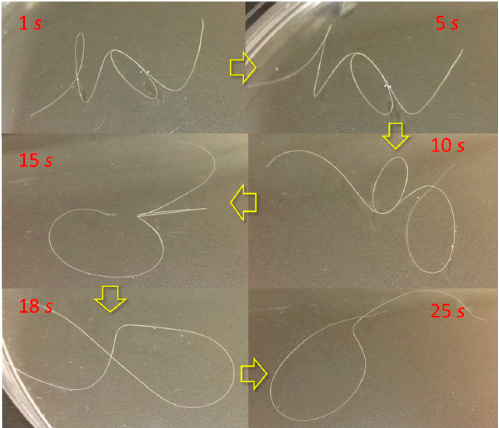
Figure 4. “Dancing” of temporary curly hair fiber on solvent for the hydration effect at different moments.